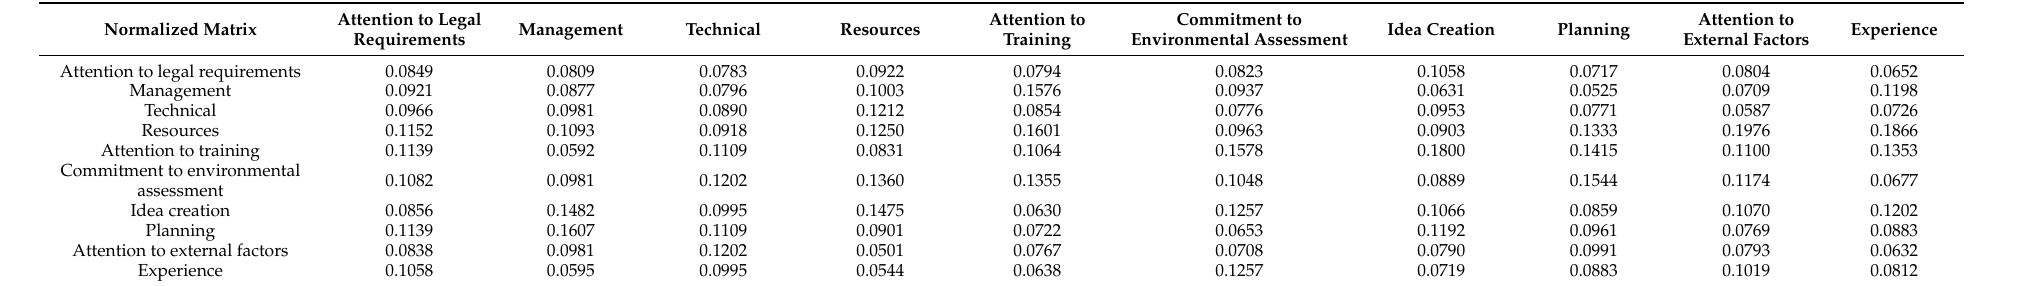
Table 3. The normalized matrix related to effective management factors and indicators in the improvement and renovation of the old tissues of the